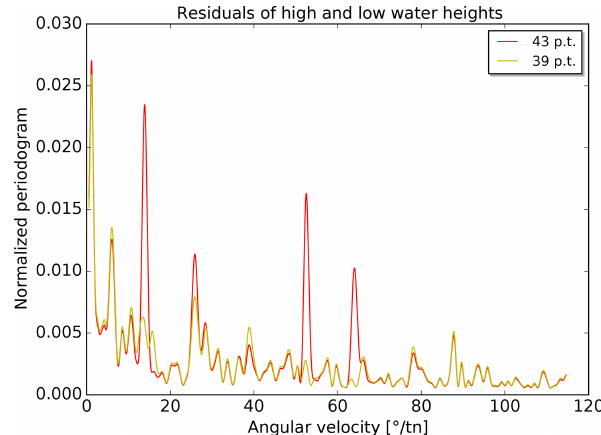
Figure 11. Same as Fig. 10 but for the high- and low-water